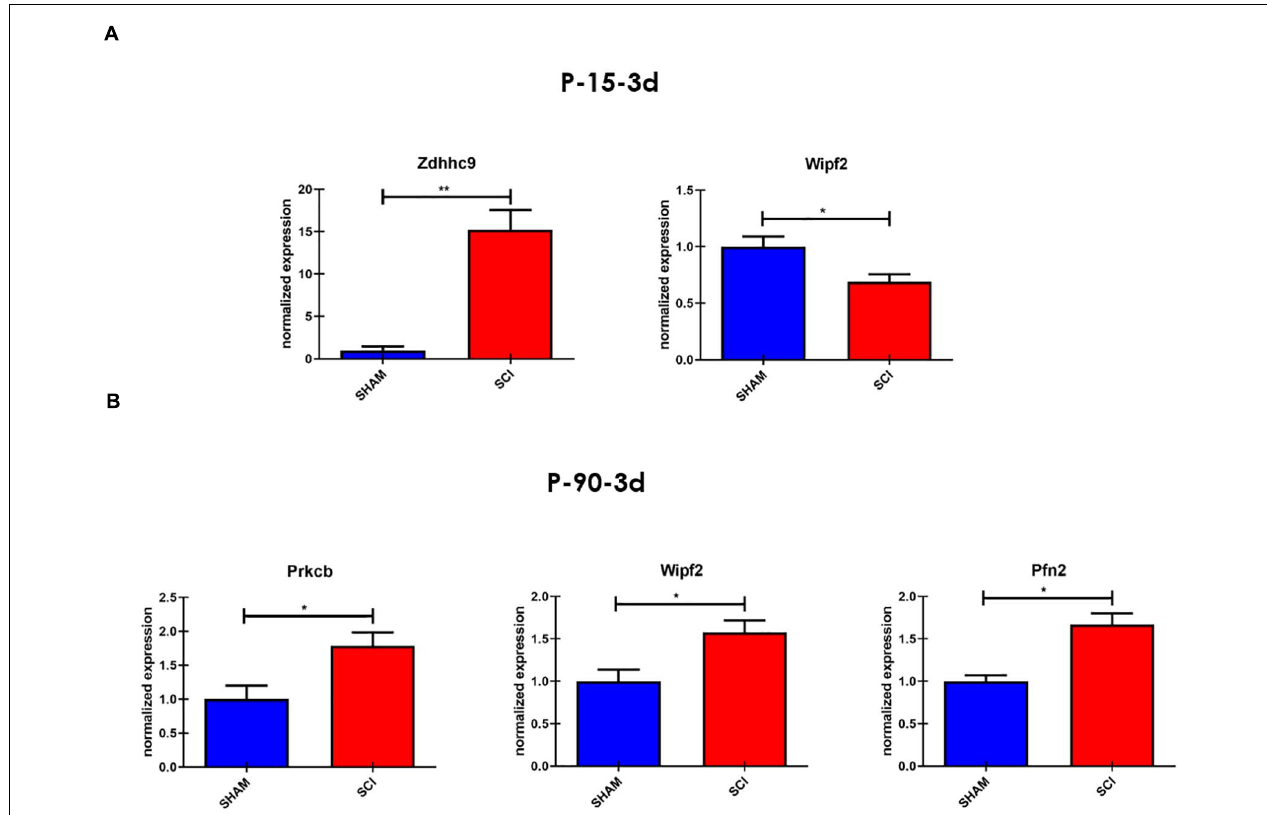
FIGURE 3 | The targets of miR-7b-3p. (A) Two/seven genes were found to be up and downregulated in P15-3d SCI group, while three/four resulted upregulated in P-90-3 days SCI (B) . The graphs express normalised relative expression values (RT-PCR) ± SEM ( t -test ** p ≤ 0.002; * p < 0.01; n = 5 for each